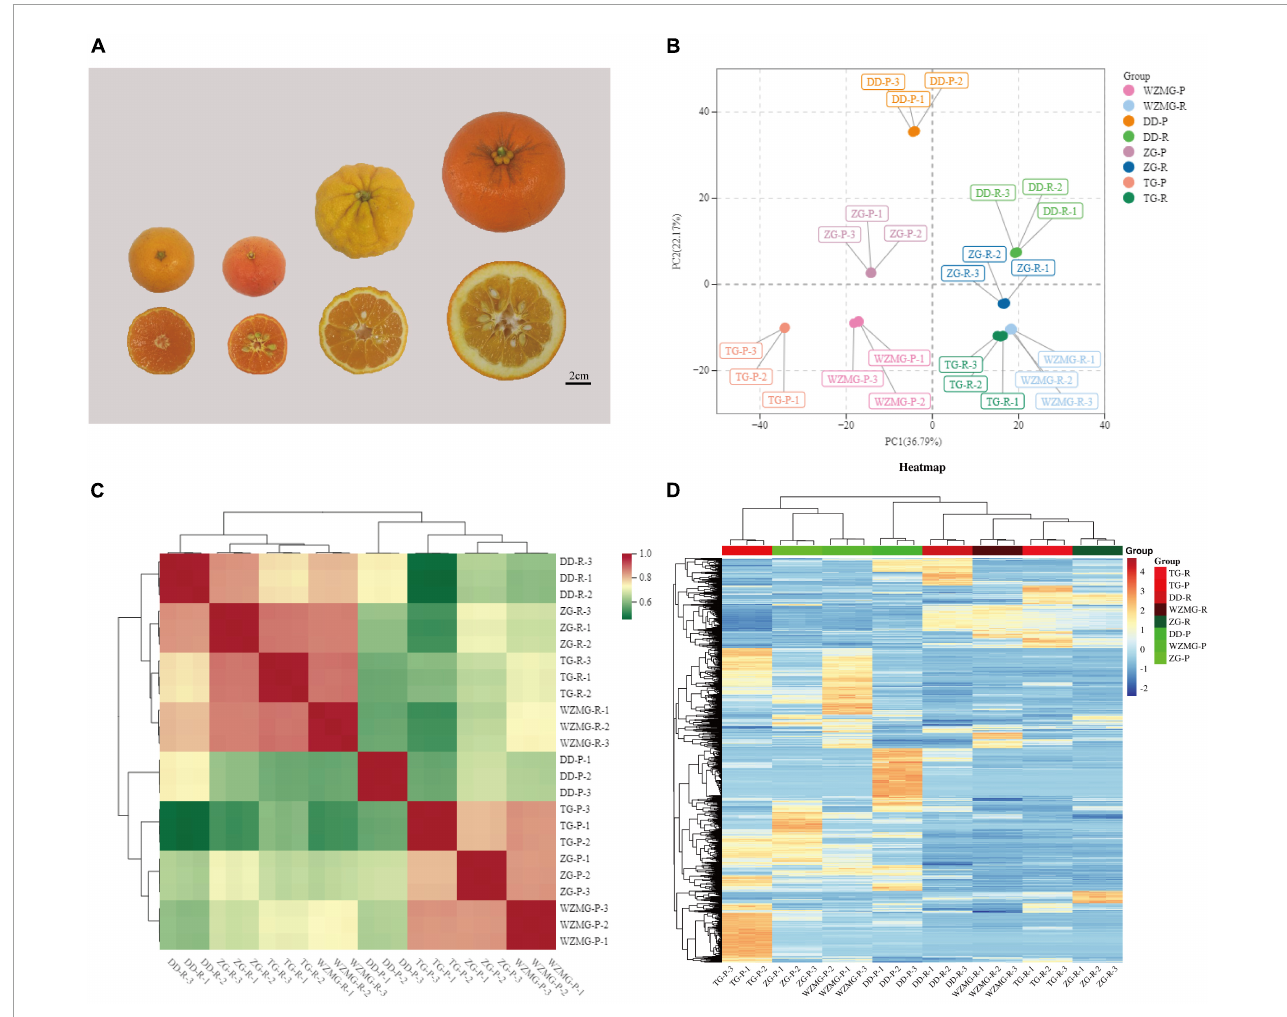
FIGURE2 Samples and metabolites profiles in the peel and pulp. (A) Samples of Zangju (ZG), Tuju (TG), Daidai (DD), and satsuma mandarin (WZMG). (B) Principal component analysis (PCA) score plot of the first and second principal components of all the samples. (C) Heatmap of biological replicate sample correlation analysis. (D) Heatmap of the total 1,126 detected metabolites of all